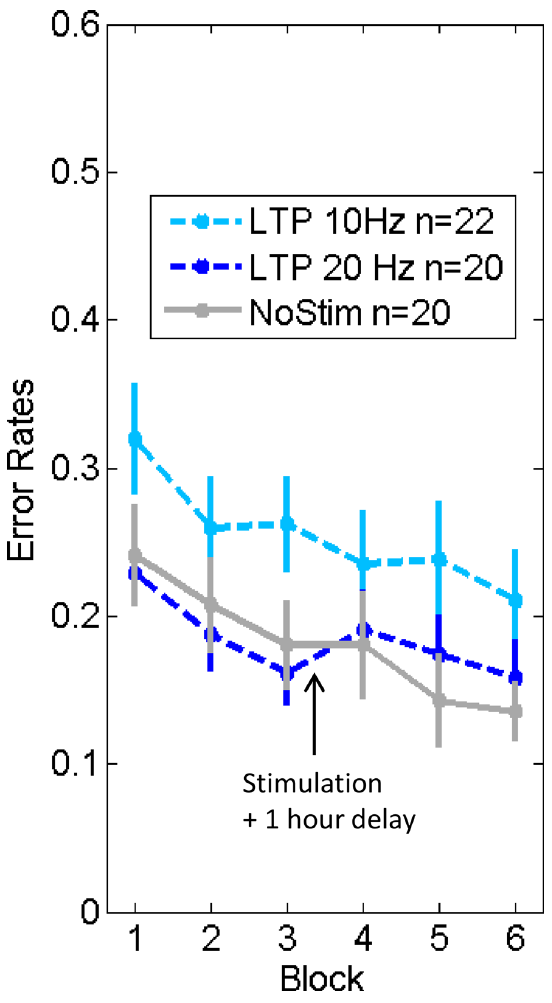
Fig 5. Experiment 4 (bars instead of faces; one hour delay). Error Rates on ‘ competitive trials ’ for each stimulation condition: LTP 10 Hz = task-relevant stimulation (luminance change) at 10Hz; LTP 20 Hz = task- relevant stimulation (luminance change) at 20Hz; NoStim = no stimulation. Arrow indicates when the stimulation was applied and followed by 1 hour delay. Error bars = +/- 1 SEM across subjects.